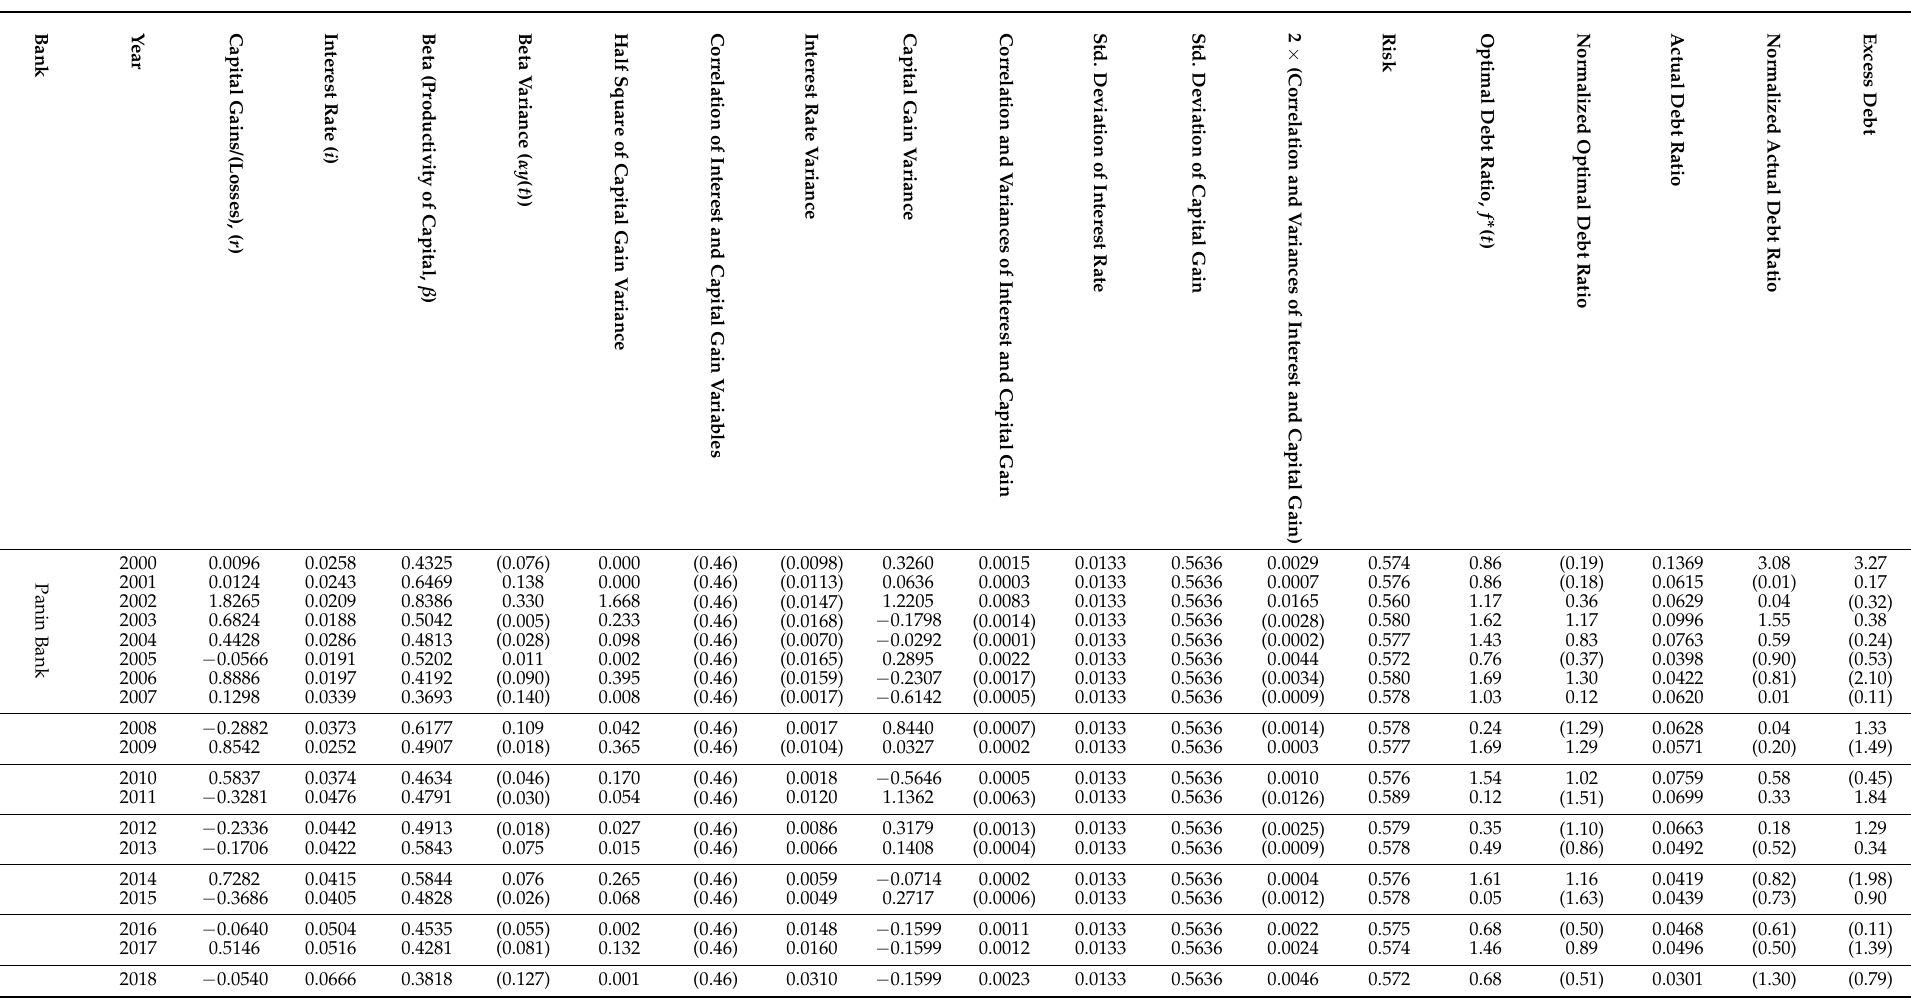
Table A12. Calculations of Optimal and E × cess Debt: Panin